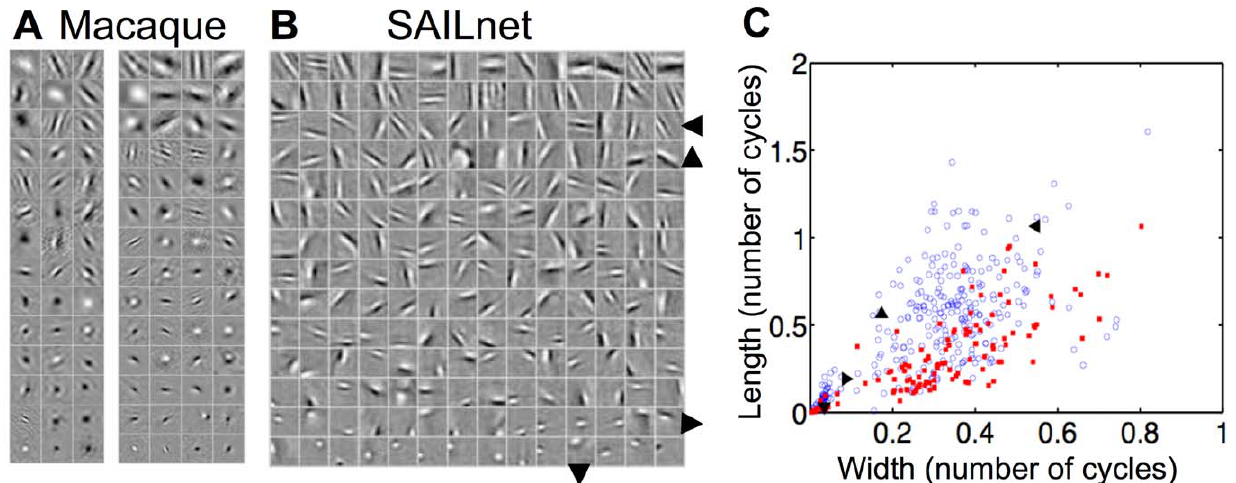
Figure 3. SAILnet learns receptive fields (RFs) with the same diversity of shapes as those of simple cells in macaque primary visual cortex (V1). (A) 98 randomly selected receptive fields recorded from simple cells in macaque monkey V1 (courtesy of D. Ringach). Each square in the grid represents one neuronal RF. The sizes of these RFs, and their positions within the windows, have no meaning in comparison to the SAILnet data. The data to the right of the break line have an angular scale (degrees of visual angle spanned horizontally by the displayed RF window) of 0 : 94 o , whereas those to the left of it span 1 : 88 o . (B) RFs of 196 randomly selected model neurons from a 1536-unit SAILnet trained on patches drawn from whitened natural images. The gray value in all squares represents zero, whereas the lighter pixels correspond to positive values, and the darker pixels correspond to negative values. All RFs are sorted by a size parameter, determined by a Gabor function best fit to the RF. The SAILnet model RFs show the same diversity of shapes as do the RFs of simple cells in macaque monkey V1 (A); both the model units and the population of recorded V1 neurons consist of small unoriented features, oriented Gabor-like wavelets containing multiple subfields, and elongated edge-detectors. (C) We fit the SAILnet and macaque RFs to Gabor functions (see Methods section), in order to quantify their shapes. Shown are the dimensionless width and length parameters ( s x | f and s y | f , respectively) of the 299 SAILnet RFs and 116 (out of 250 RFs in the dataset) macaque RFs for which the Gabor fitting routine converged. These parameters represent the size of the Gaussian envelope in either direction, in terms of the number of cycles of the sinusoid. The SAILnet data (open blue circles) span the space of the macaque data (solid red squares) from our Gabor fitting analysis; SAILnet is accounting for all of the observed RF shapes. We highlight four SAILnet RFs with distinct shapes, which are identified by the large triangular symbols that are also displayed next to the corresponding RFs in panel (B).